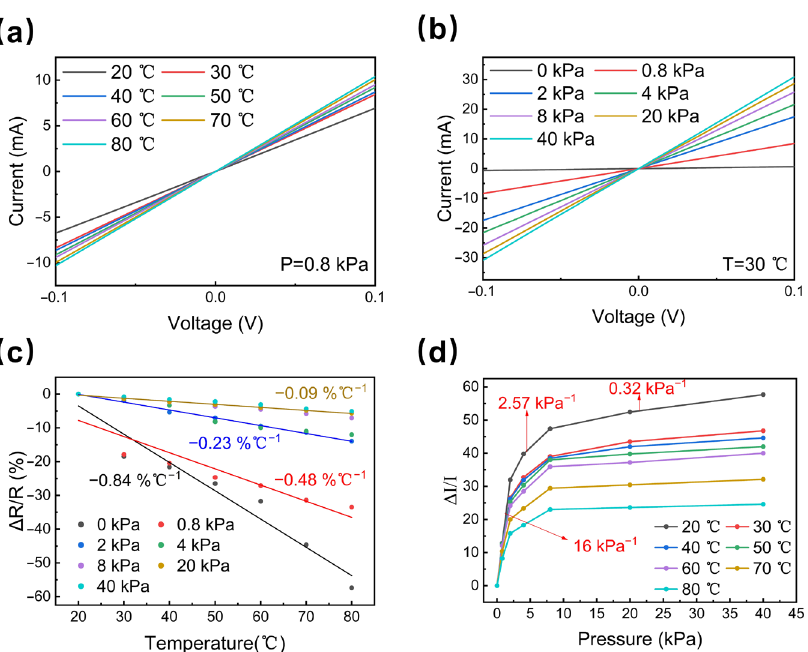
Figure 5. Performance of pressure–temperature co-detection: ( a ) I–V curves in the temperature range of 20 °C to 80 °C at 0.8 kPa; ( b ) I–V curves in the pressure range of 0 kPa to 40 kPa at 30 °C; ( c ) resistance change rates and temperature sensitivity curves under different pressures in the range of 0 kPa to 40 kPa; ( d ) current change rates and pressure sensitivity curves at different temperature values in the range of 20 °C to 80 °C. Table 1. A comparison with the previous work [34–37].